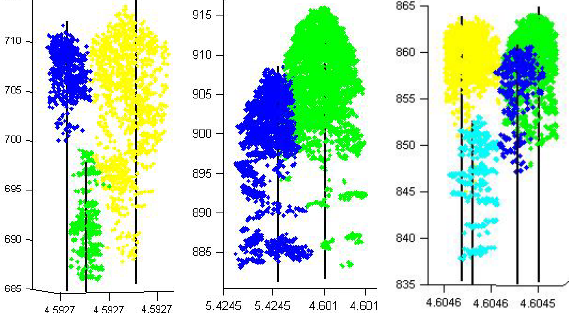
Figure 3. Single tree segmentation using normalized cut with the reference trees as black lines.